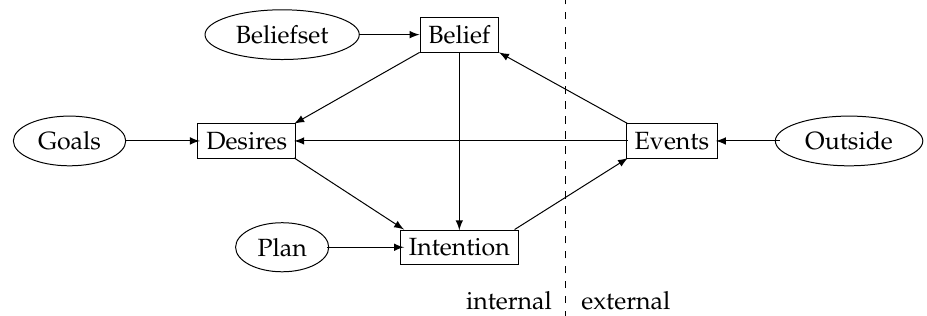
Figure 1. Our simplified interpretation of the BDI architecture, inspired by works of Jacob- son et al. [33]. The beliefs (knowledge) influence the desires and intentions. The goals lead to the next desire with the highest priority which in turn leads to the next intention, based on the available plans. The ability to react to external and system-initiated events presents a method of an intelligently reacting